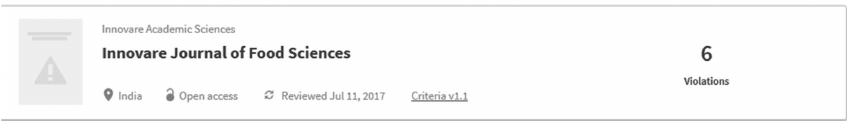
Fig. 8: An example of discrepancy between the reviewing date and the criteria version used for a journal entry as it appears on Cabell’s blacklist. Screenshot captured on September 8th, 2019.